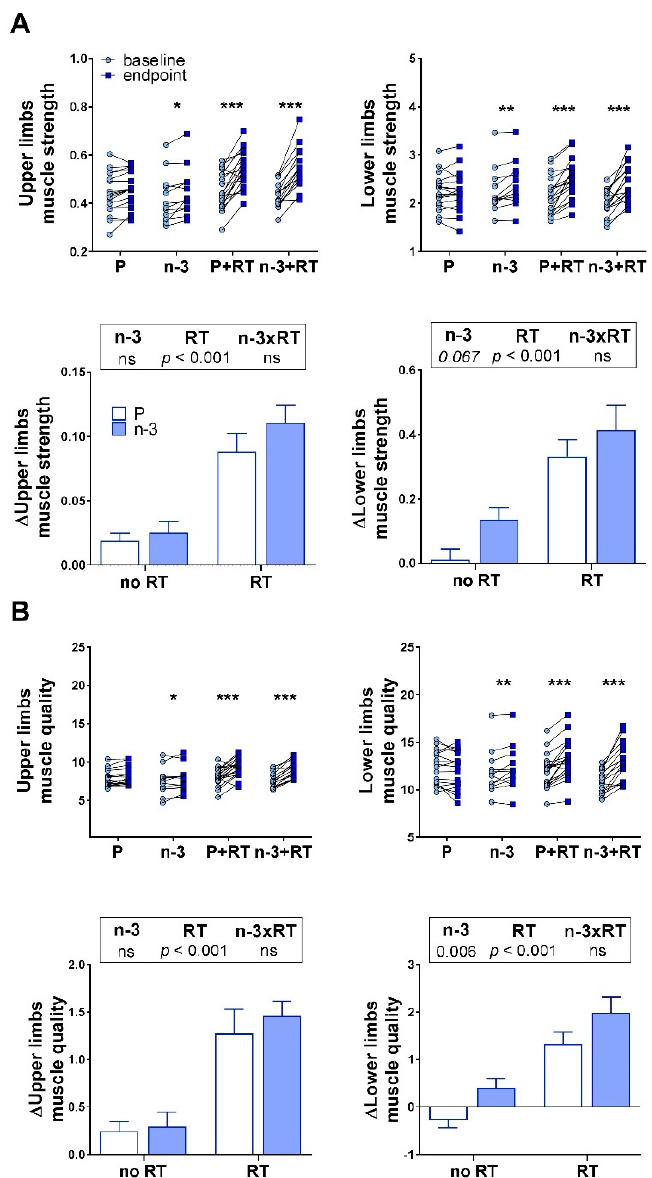
Figure 2. Effects of 16 weeks of DHA-rich n-3 PUFA (n-3) supplementation and/or resistance training (RT) on upper limbs (left panels) and lower limbs (right panels) muscle strength ( A ) and muscle quality ( B ). Muscle strength was calculated as 1-RM (kg)/body weight (kg); and muscle quality, as 1-RM (kg)/local lean mass (kg). Baseline-endpoint differences (joined dots graphs) were studied by paired Student’s t -test or Wilcoxon’s signed-rank test after testing for normality. *** p < 0.001; ** p < 0.01; * p < 0.05 vs. baseline. Differences in changes between groups (bar graphs) were compared by